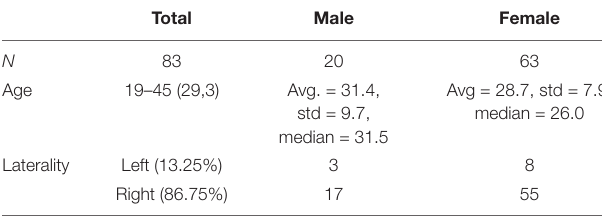
TABLE 1 | Distribution of our